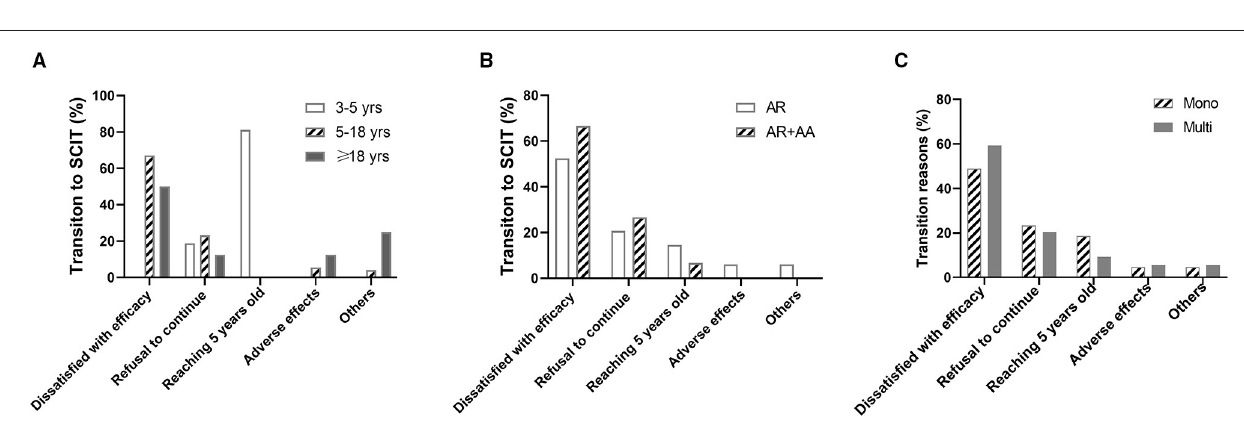
FIGURE 6 | Reasons for transition to SCIT in patients with different ages, underlying diseases, and sensitization statuses. (A) Transition reasons in different age groups. (B) Transition reasons in allergic rhinitis (AR) patients with or without allergic asthma (AA). (C) Transition reasons in patients sensitized to HDM alone (Mono) and patients sensitized to other aeroallergens in addition to HDM